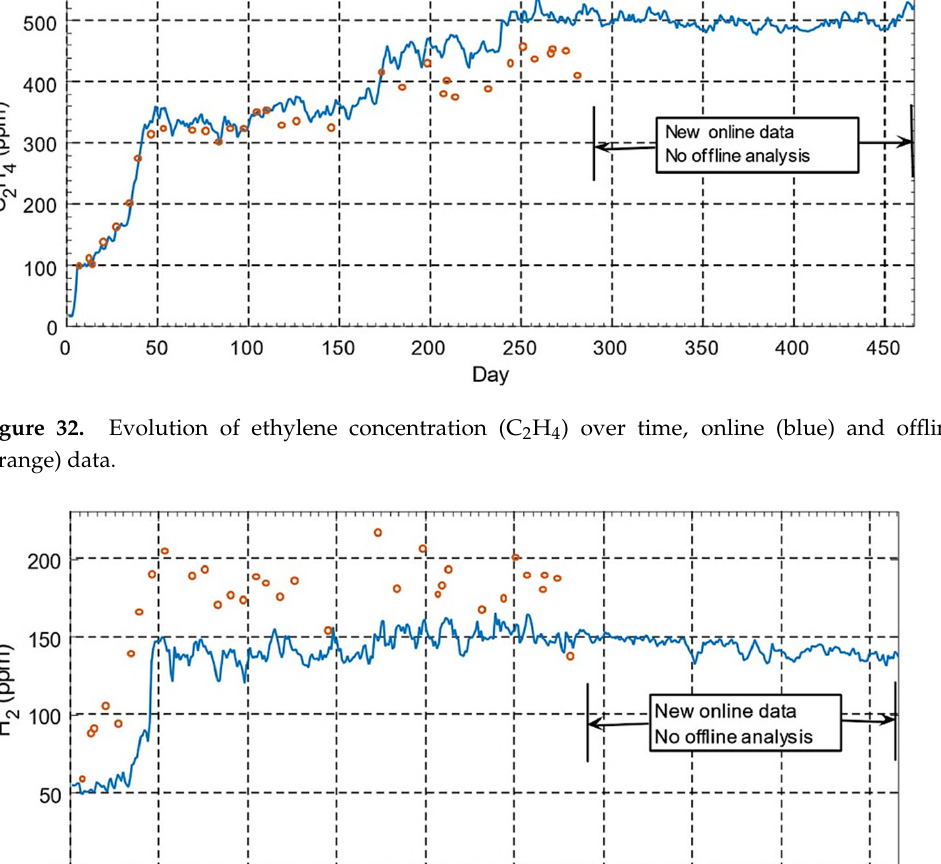
Figure 33. Evolution of hydrogen (H 2 ) concentration over time, online (blue) and offline (orange) data.